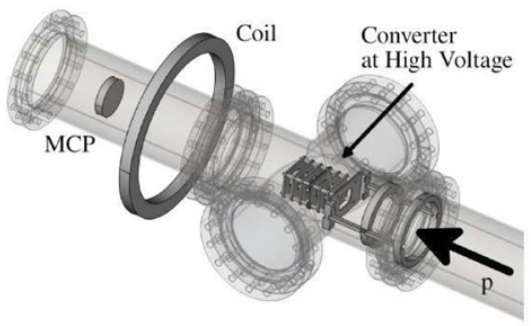
Figure 17. Experimental setup for measuring the secondary electron production in thin foils by protons. Different foils were tested (carbon foils coated with MgO and LiF). The foils are placed in the center of the degrader.